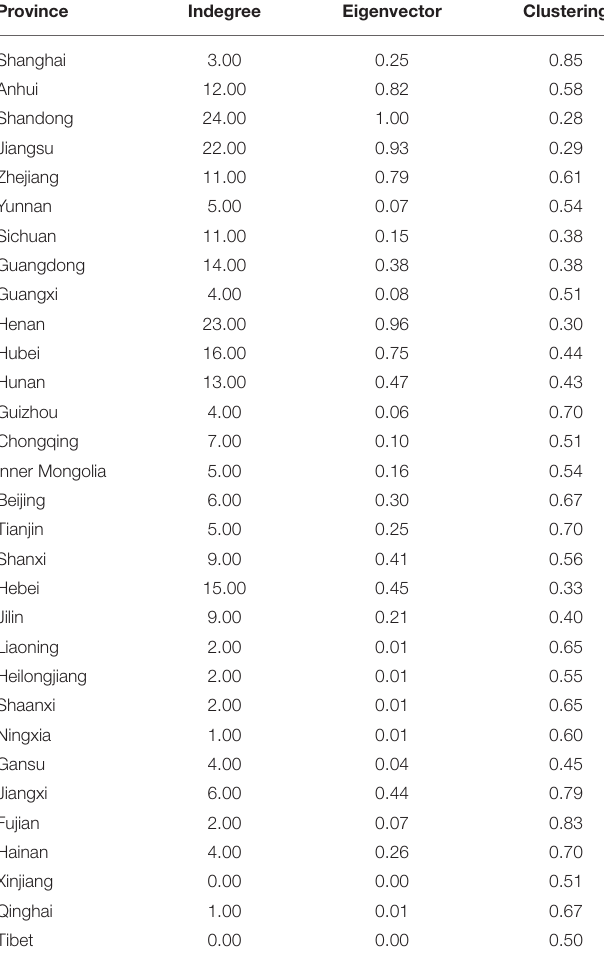
TABLE 1 | Characteristics of the economic network of China in 2018. Province Indegree Eigenvector